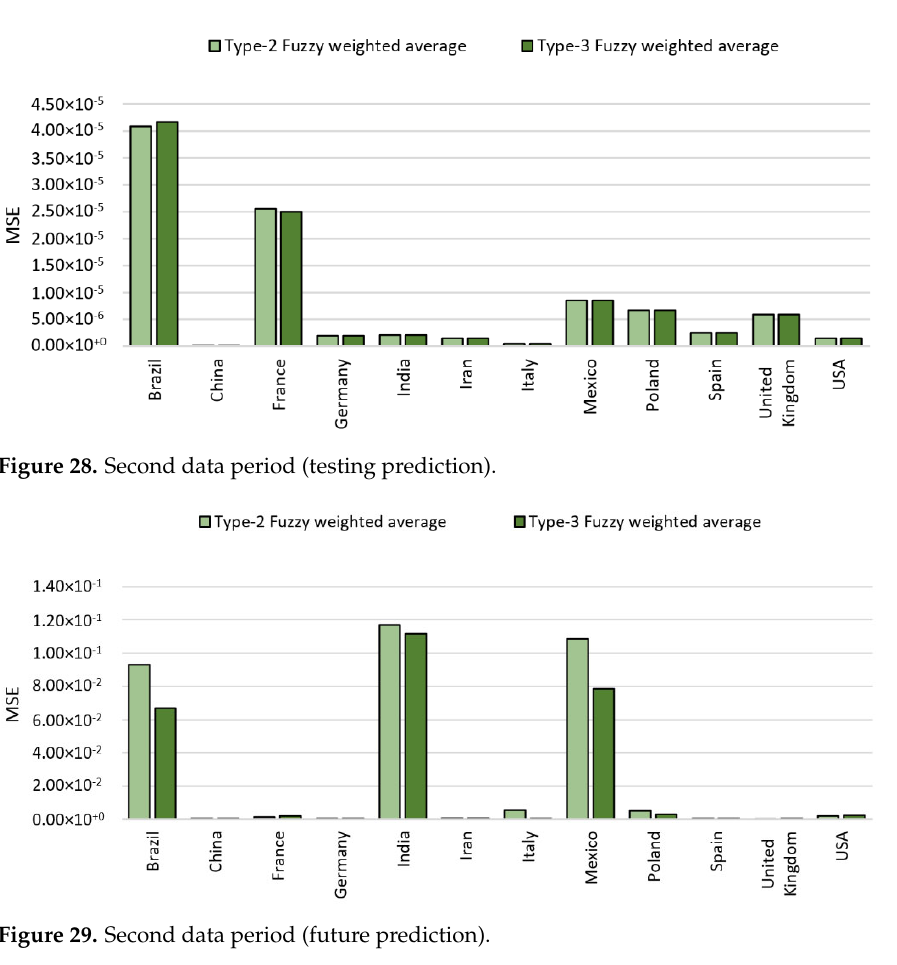
Figure 29. Second data period (future prediction).